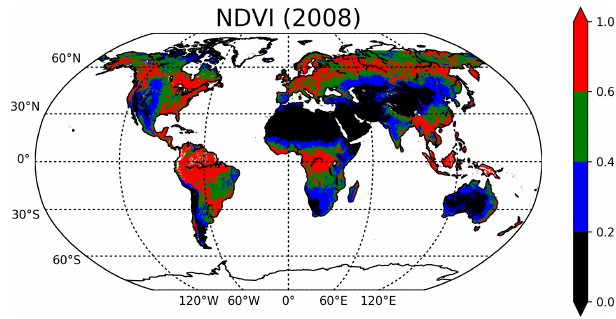
Figure 10. Spatial distribution of annual mean NDVI for 2008 from GRASP/Models L3